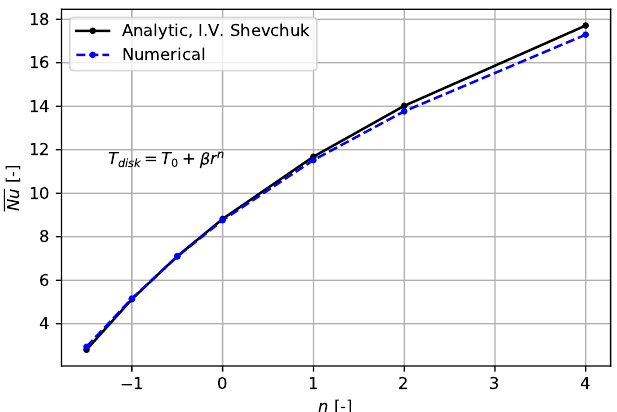
Figure 9. Comparison of the numerical and analytical solution [61] of the average Nusselt number for different temperature distributions at Pr = 0.72, Re = 720.